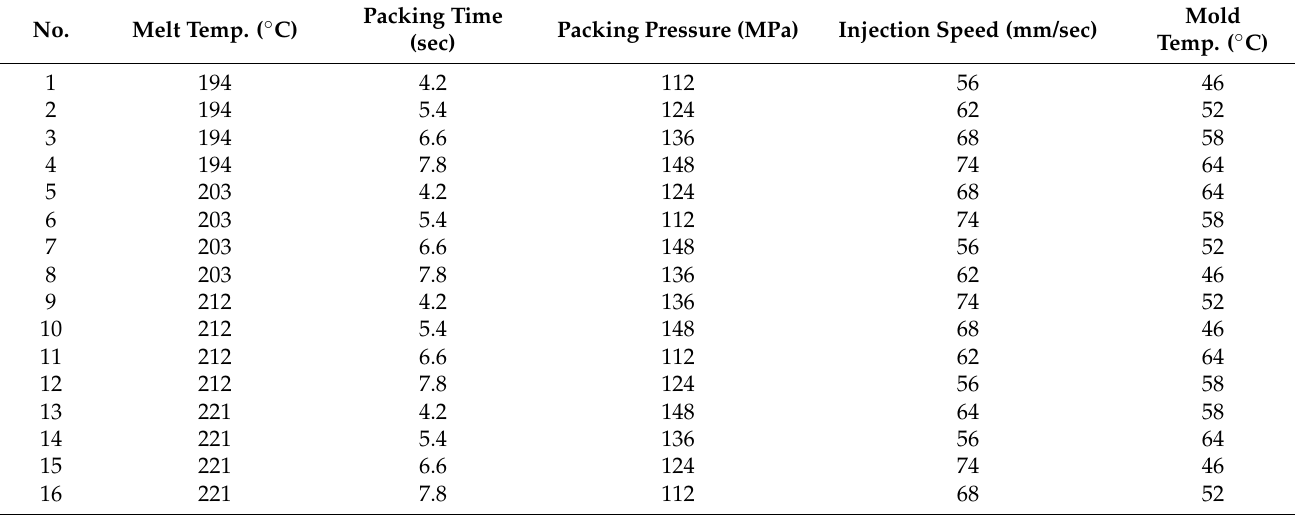
Table 11. Validation data for the round plate